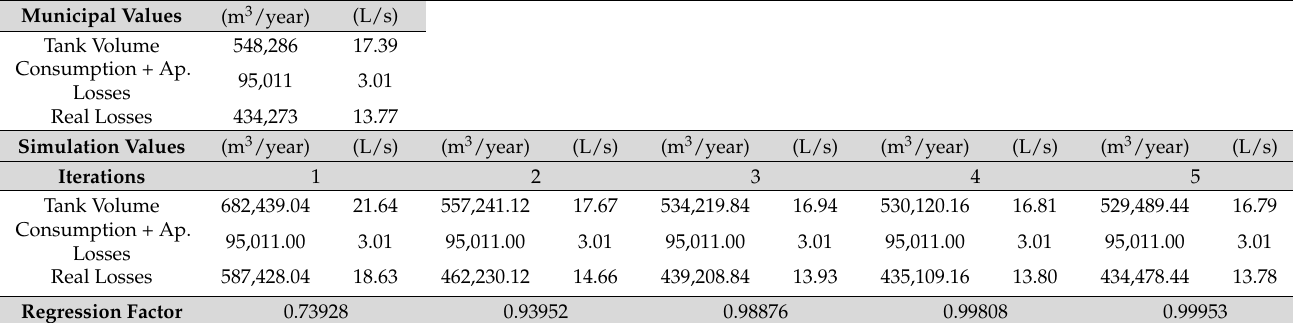
Table 3. DT model learning for real